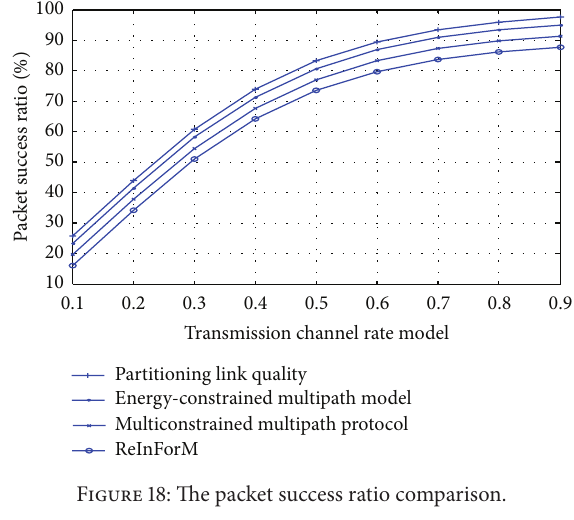
Figure 18: The packet success ratio